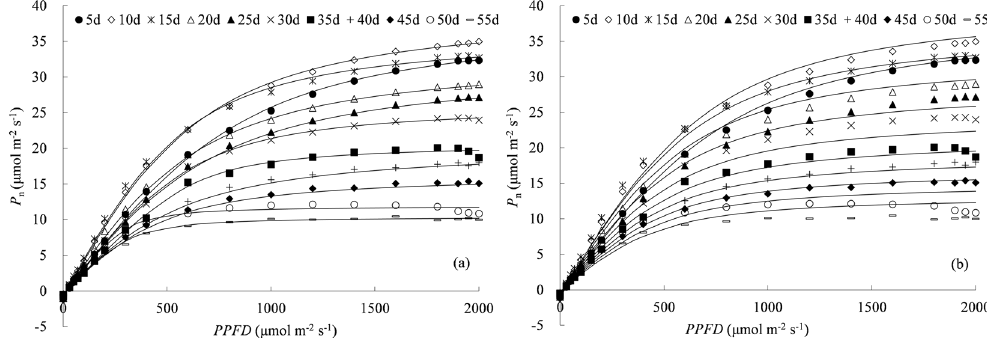
Figure 5. Net photosynthetic rates ( P n ) calculated by ( a ) the non-rectangular hyperbola (NRH) and ( b ) the general NRH equation for calibration data. Lines represent the modelled P n , symbols are the observed P n (“ n d” in legend is the nominal leaf age for each leaf age group with ± 2 days